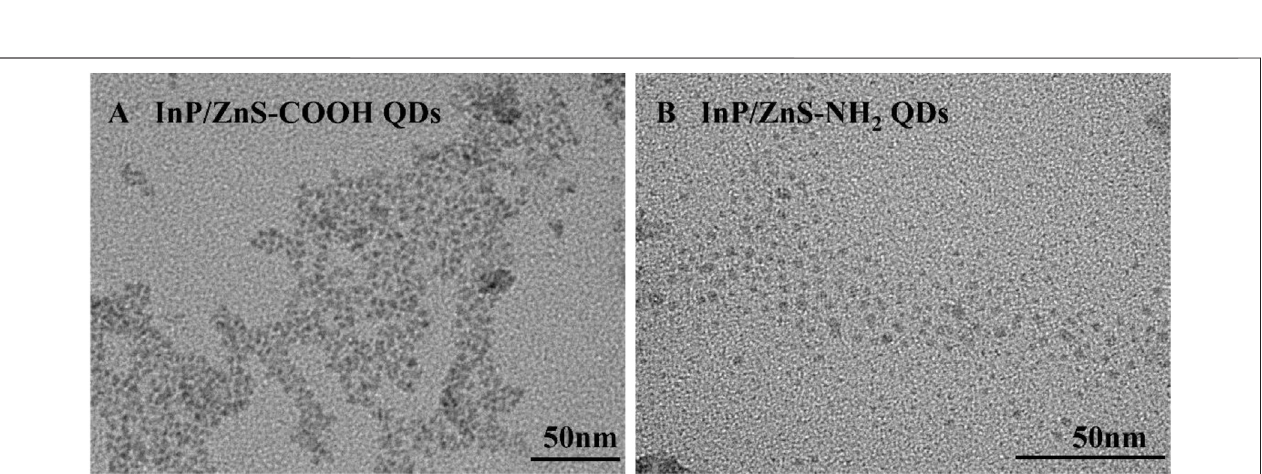
FIGURE 3 | The TEM images of InP/ZnS QDs coated with carboxyl (A) and amino (B) groups.